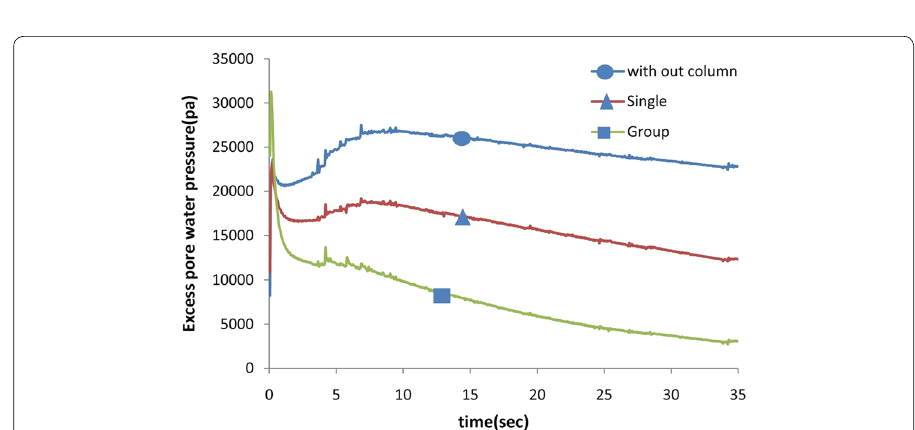
Fig. 21 Changes of excess pore water pressure against